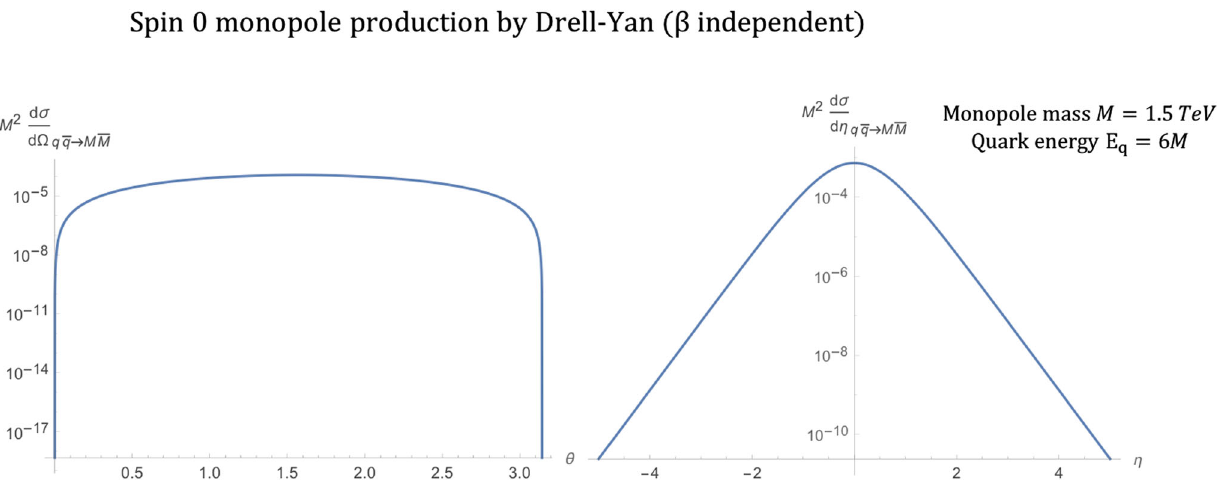
Fig. 6 Differential cross section distributions for the production of spin-0 monopoles of mass M = 1 . 5 TeV via DY from massless quarks with √ β = 1 at s qq = 2 E q , where E q = 6 M , as a function of the scattering angle θ (left) and the pseudorapidity η (right) q